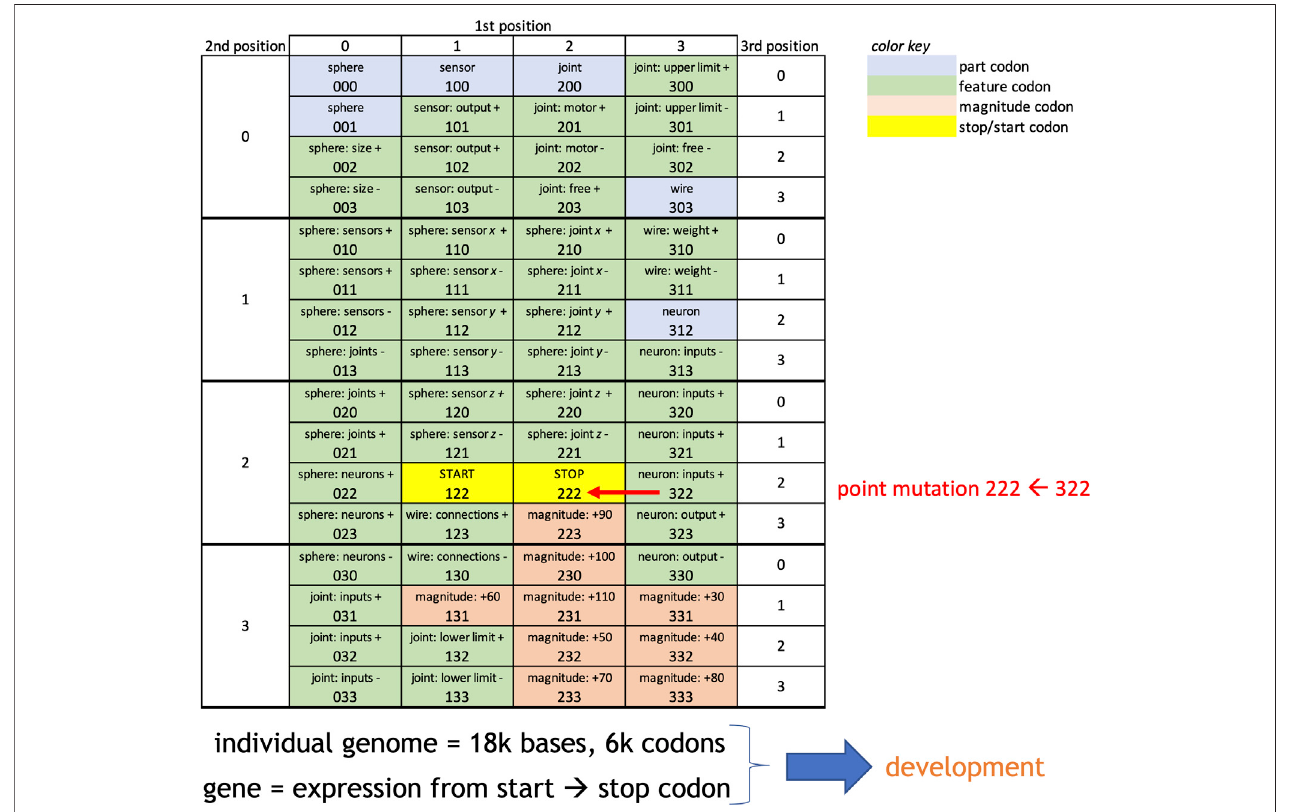
FIGURE1| Geneticcode and mutation errorsfor embodied robots. Inspiredby thegenetic codeoflifeforms,thisgeneticcode usestriplet codons tosignify parts, featuresoftheparts,magnitudesoftheparts,andstartandstopcodons.Inanindividual,thesecodonsareexpressedastranscripts(see Figure2 )iftheyoccurbetween thestartandstopofagene.Eachindividualhasagenomethatis18kbaseslong,allowingfor6kpossiblecodonsandmultiplegenes.Pointmutationsarerandom.They occur by changing, for example (see red text), the fi rst digit of the codon from 3 to 2, which changes the codon from 322 to 222, turning a feature codon into a property codon. Point mutations occur only when the genome of a parent is replicated to make the genome of an asexually reproduced offspring.